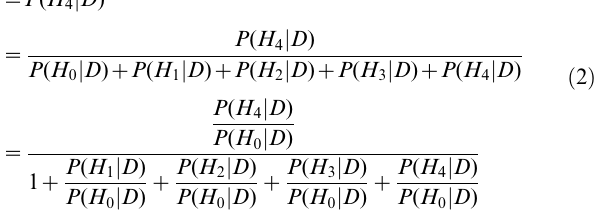
Figure S1 Simulation analysis with a shared causal variant between two studies, comparing results using imputed versus not imputed data where the causal SNP is included in both the cases. The two datasets used are one eQTL (sample size 966 samples) and one biomarker, and each plot shows different sample sizes for the biomarker dataset. The variance explained by the causal variant for both the traits is colour coded. The x- axis shows the estimated PP4 for 1,000 simulations using data